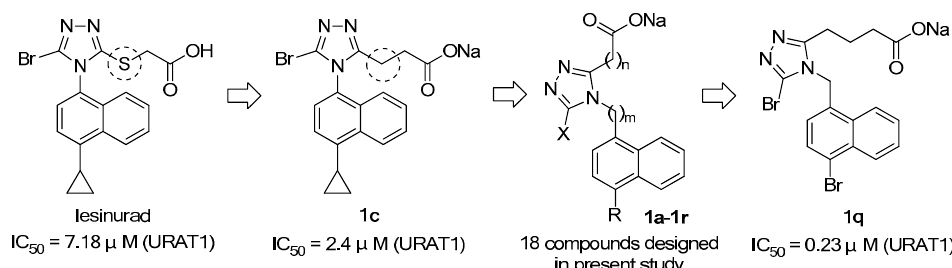
Figure 1. Structures of approved URAT1 inhibitors.